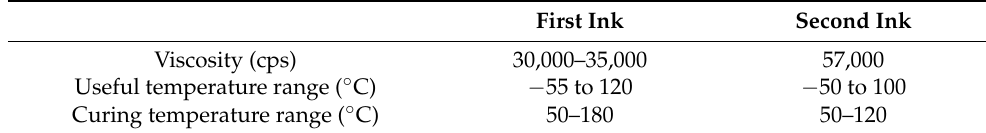
Table 2. Properties of the conductive